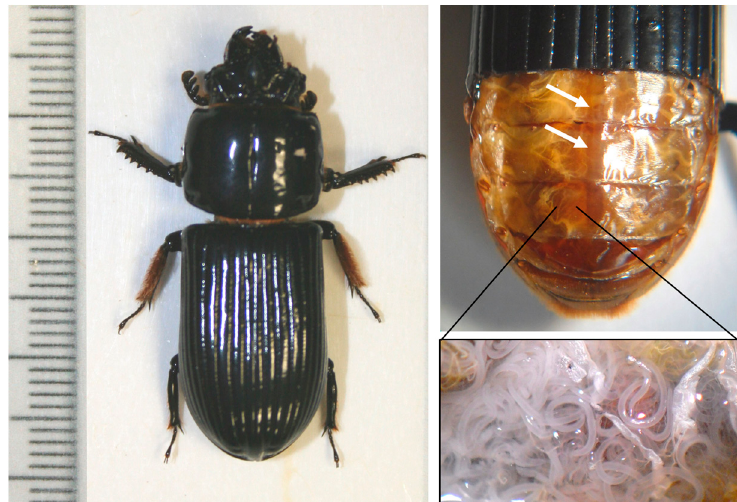
Figure 1. Intact horned passalus beetle, Odontotaenius disjunctus , left. Right top image shows a beetle with the lower portion of the elytra removed to allow visualization of the dorsal vessel (white arrows). A video of the dorsal vessel pumping is available in the Supplemental files. Lower right image shows nematode parasite, Chondronema passali , that inhabits the abdominal cavity of O. disjunctus .